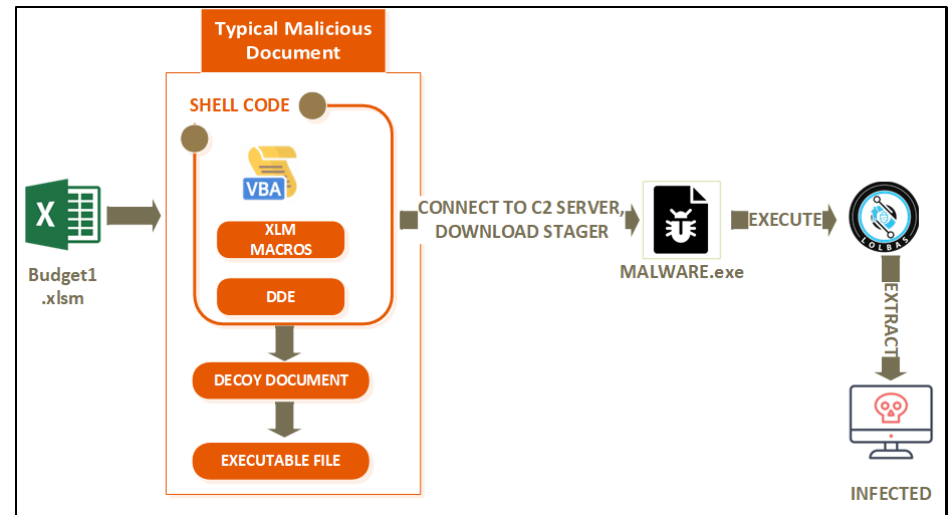
Figure 5. Malicious document execution process .